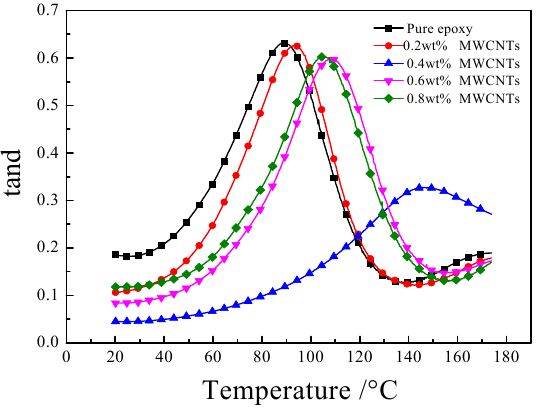
Figure 9. tan δ – T curves of epoxy nanocomposites with the content of various PABA-modified MWCNTs.